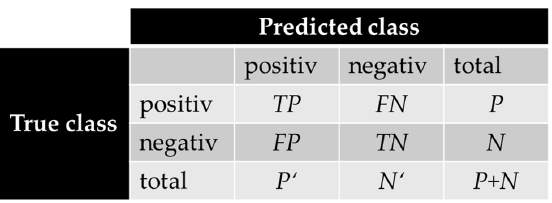
Figure 10. Confusion matrix for classification tasks according to [51–53].